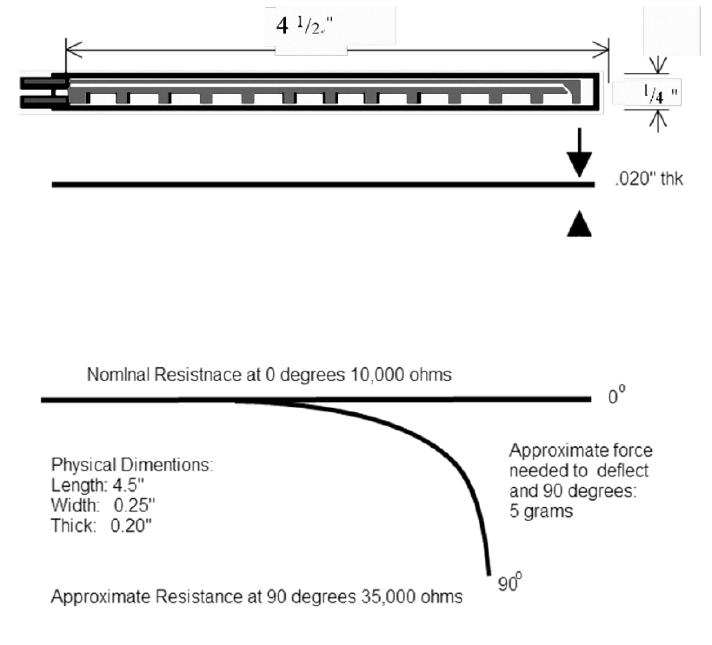
Figure 8. Characteristics of bending-type sensor resistance [22].